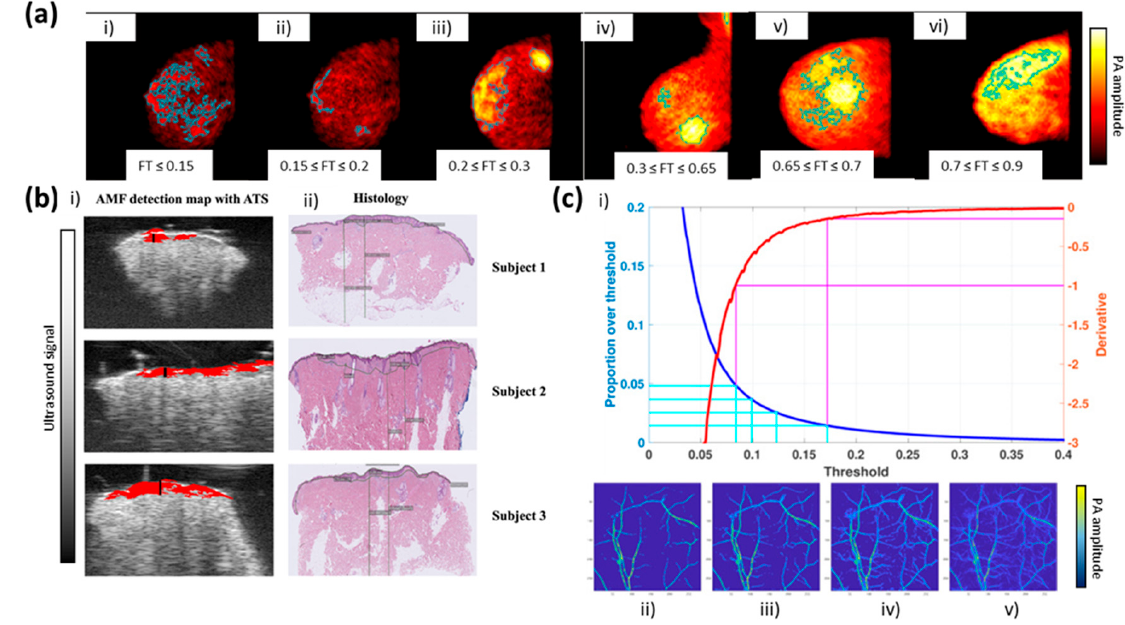
Figure 1. ( a ) BI-RADS 1–6 levels based on leveling tumor mass by foreground threshold (FT) values (blue boundary) and breast skin layer: (i) negative (FT ≤ 0.15); (ii) benign (0.15 ≤ FT ≤ 0.2); (iii) probably benign (0.2 ≤ FT ≤ 0.3); (iv) suspicious (0.3 ≤ FT ≤ 0.65); (v) highly suggestive of malignancy